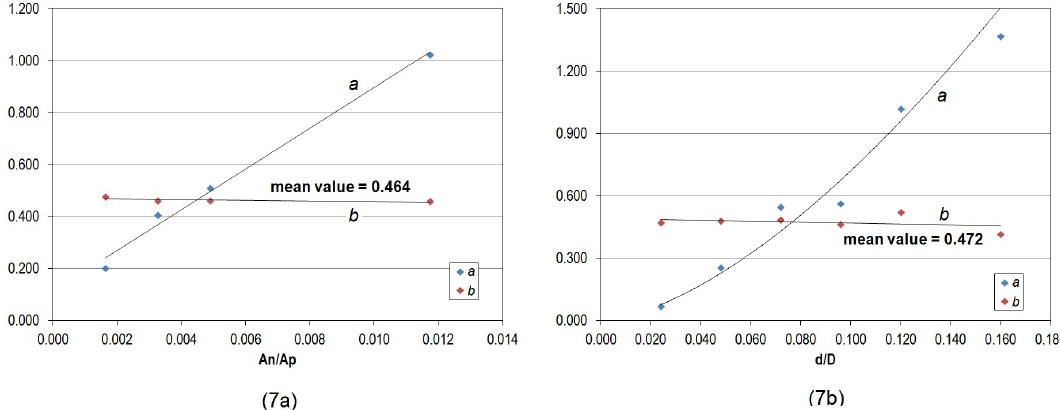
Figure 7. Discharge coe ffi cients according to: (a) A n / A p ratio (rectangular nozzles); (b) d / D ratio (round nozzles). Dynamic tests on ductile iron